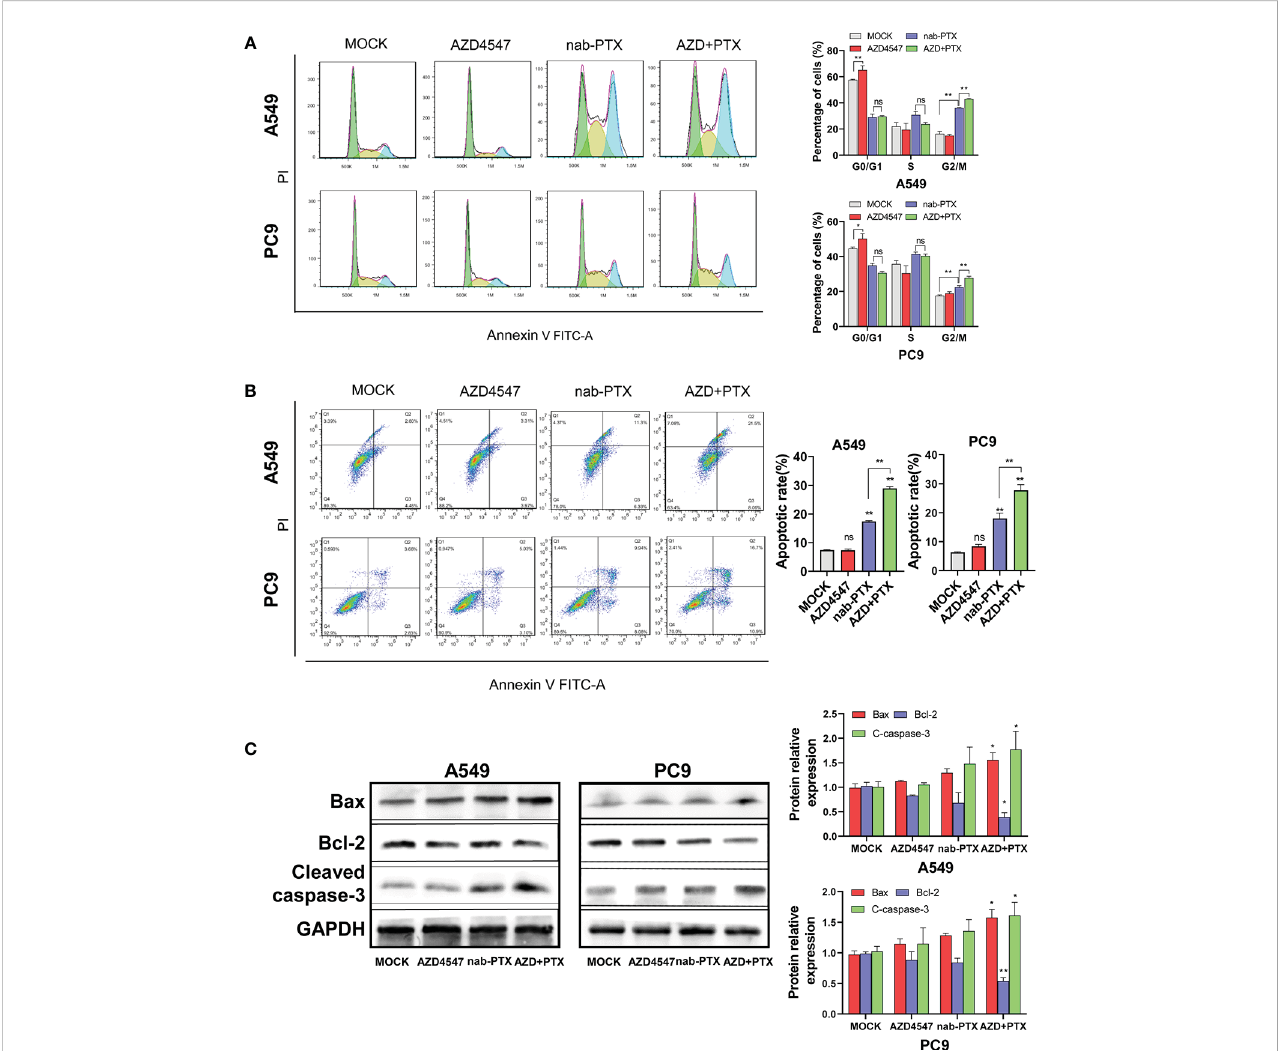
FIGURE 3 Cell cycle and apoptosis analysis. (A) Cells cotreated with AZD4547 and nab-PTX exhibited a signi fi cantly higher rate of apoptosis than those treated with nab-PTX alone. (Left: Representative FACS pro fi les are shown, and the cell population in the Annexin V-FITC/PI quadrant represents apoptotic cells. Right: The percentage of apoptotic cells is shown in histogram form). (B) Cell cycle arrest in the G2/M phase was more evident when AZD4547 was combined with nab-PTX than when nab-PTX was used alone (Left: Cell cycle distribution of cells after different treatments for 24 h. Right: Histogram showing the percentage of cells in each phase of the cell cycle). (C) AZD4547 regulated the expression of the apoptosis-associated proteins Bax, Bcl-2, and cleaved caspase-3. ns, no signi fi cance, *: p< 0.05, **: p<